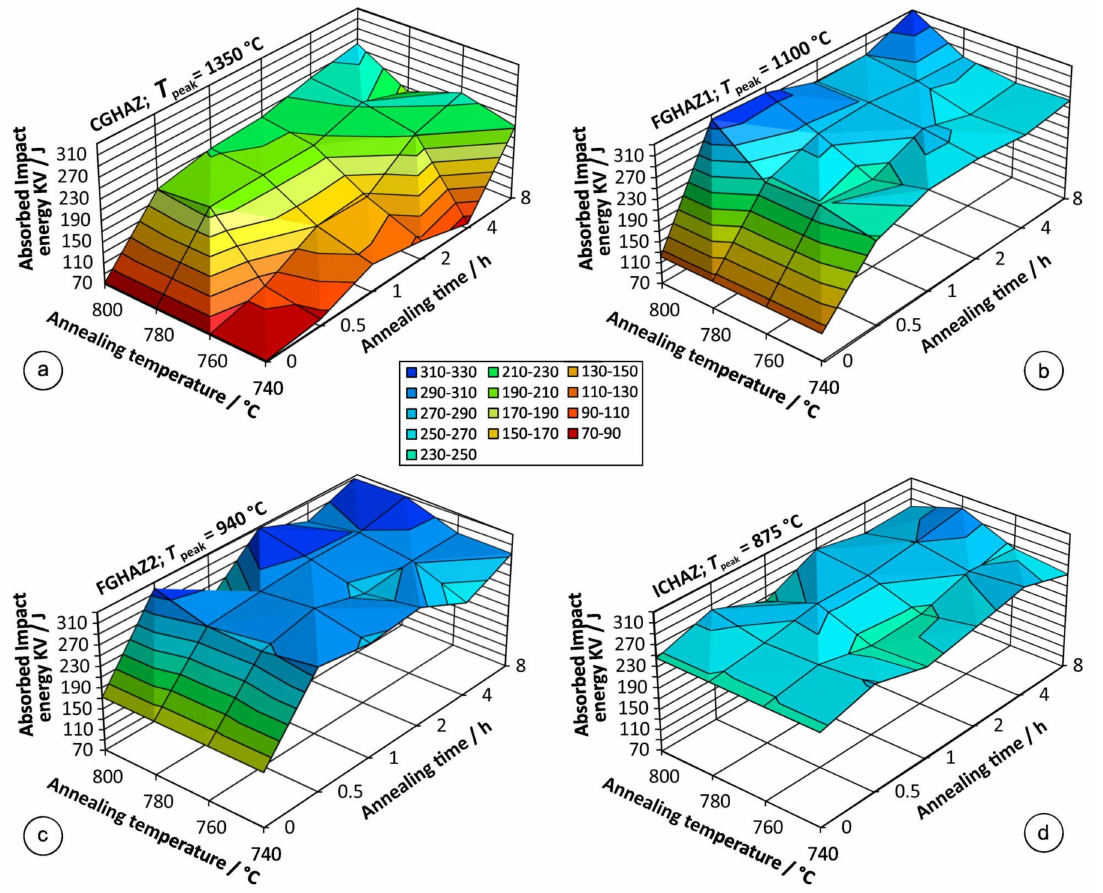
Figure 6. The total impact energies KV in individual HAZ subzones: ( a ) CGHAZ; ( b ) FGHAZ-1; ( c ) FGHAZ-2; ( d ) ICHAZ; Annealing time t = 0 denotes as-welded